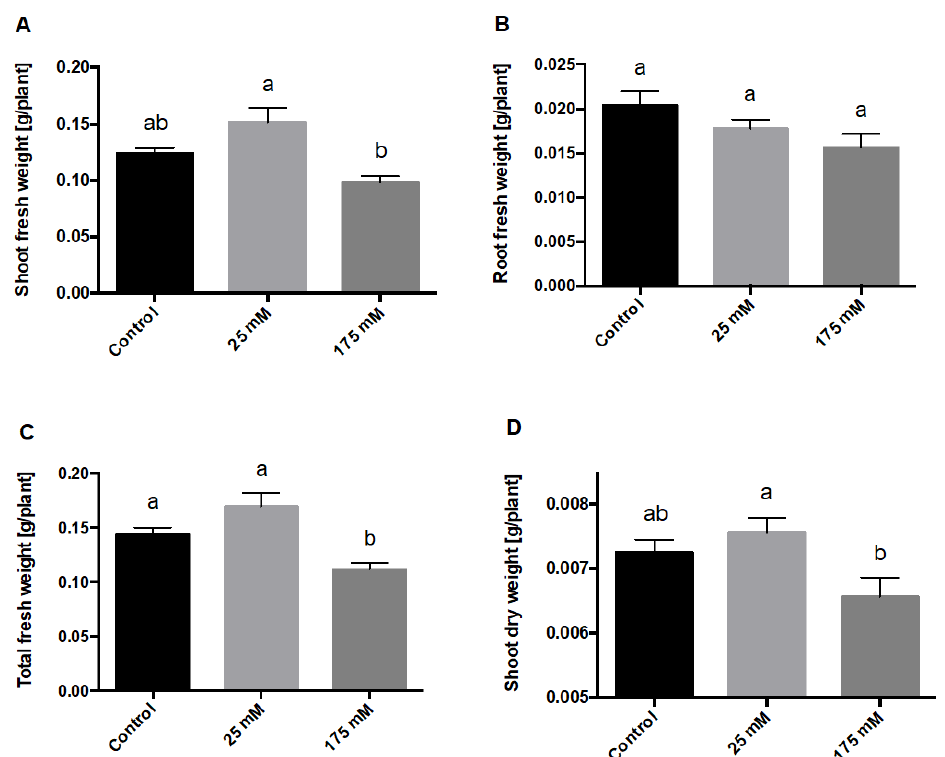
Figure 3. Fresh and dry weight of S. lycopersicum plants after low and high salt treatments. S. lycopersicum seedlings were treated with low and high concentrations of NaCl (0, 25, and 175 mM). The roots and shoots were dissected and weighed after 10 days of NaCl treatment. ( A ) Shoot fresh weight, ( B ) root fresh weight, ( C ) total fresh weight, and ( D ) shoot dry weight. The letters a and b represent statistically significant differences with p < 0.05. Error bars represent the standard error of the mean.